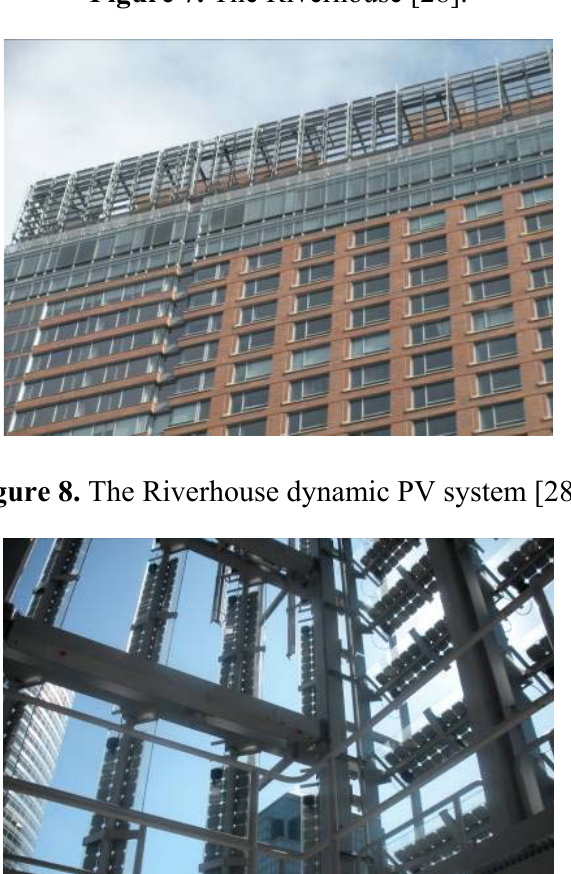
Figure 7. The Riverhouse [28].